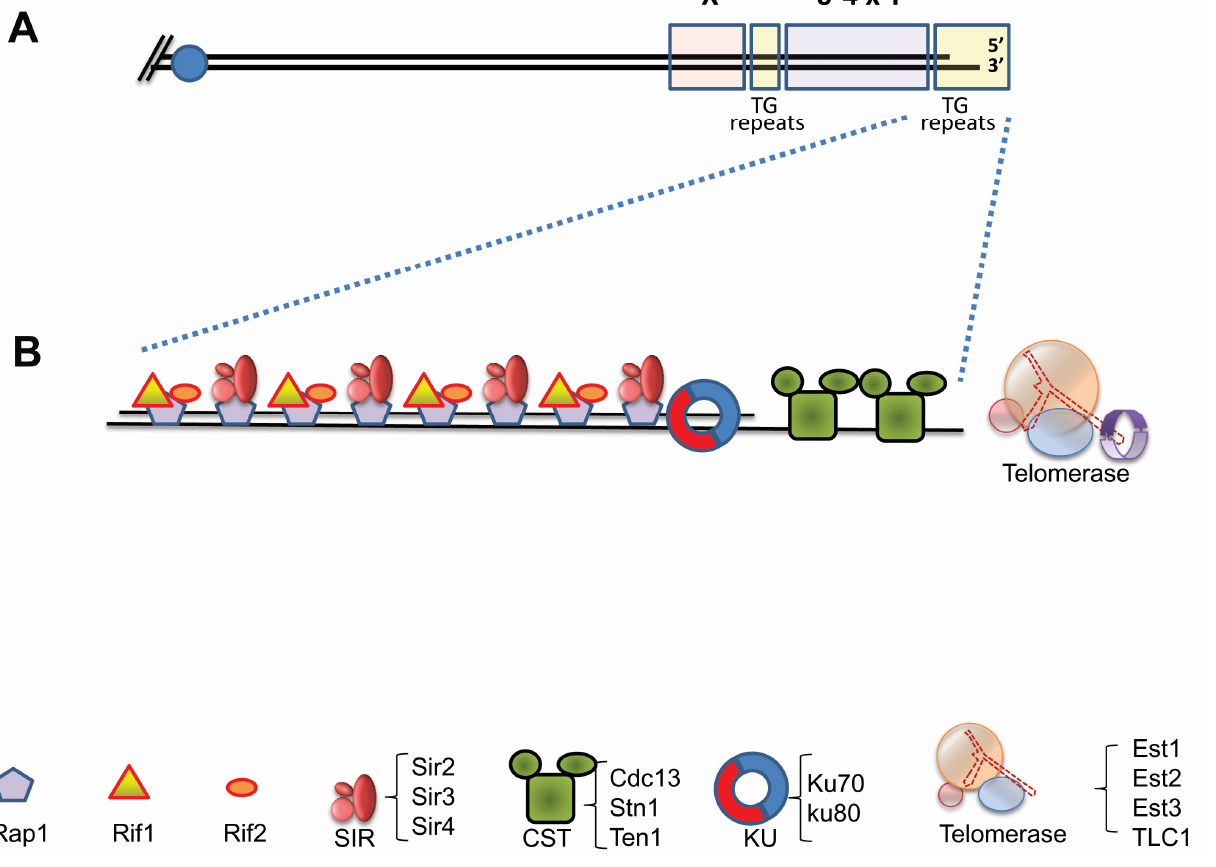
FIGURE 1: Structure of the yeast telomere. (A) Schematic representation of a yeast telomere. All yeast chromosomes carry subtelomeric repeats called X elements, and between 0 and 4 copies of another sub-telomeric element, the Y’ sequences. Telomeric repeats are composed of variations of the T(G1-3) formula. The TG-rich strand (with its 3’ OH) is longer than the complementary strand (TG overhangs). (B) Sche- matic representation of the telomeric chromatin, with representative proteins. Rap1 binds the telomeric repeats, and Rif1, Rif2 and the SIR proteins bind to Rap1. The Ku heterodimer binds to telomeric dsDNA and the CST complex binds the terminal ssDNA end. Telomerase is re- cruited to telomeres present in an “extensible” configuration by interactions with the